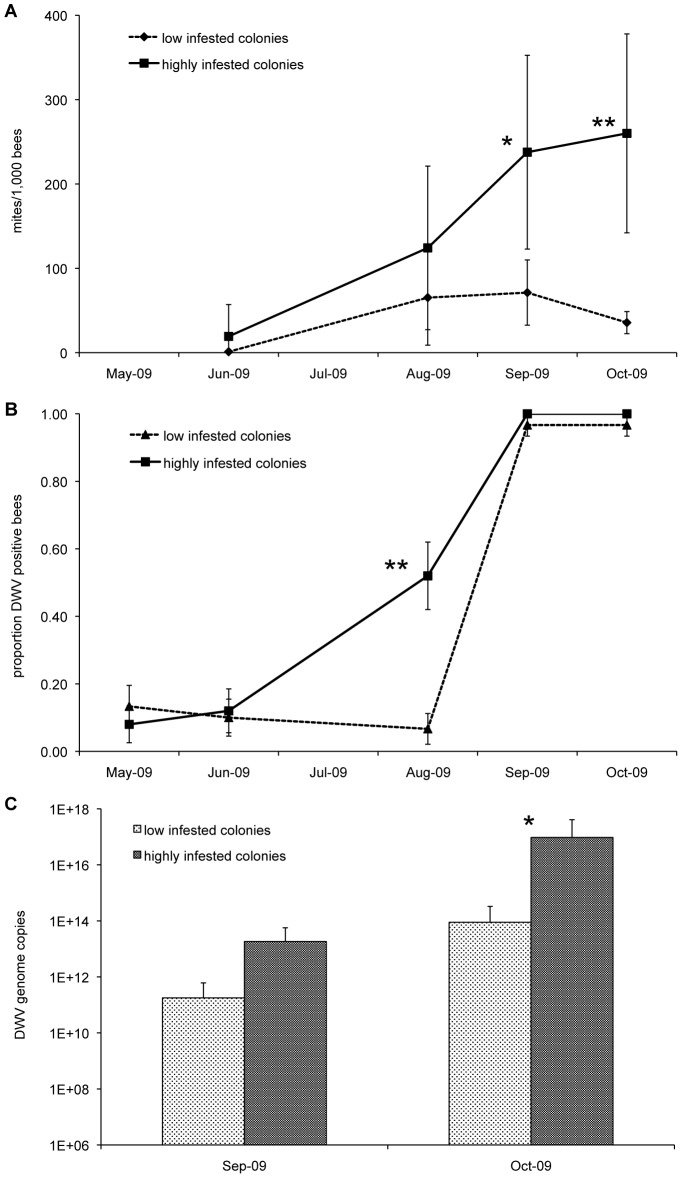
Mites and DWV in low and highly infested colonies.(A) Number of mites per 1,000 bees. (B) Seasonal prevalence of Deformed wing virus (DWV) in low and highly infested colonies. (C) Number of DWV genome copies in infected honeybees, collected in September and October from low and highly infested colonies. The error bars indicate the standard deviation; mean values significantly different are denoted with asterisks (*P≤0.05; **P≤0.01). Mite population steadily increased along the season in untreated colonies; DWV prevalence approached 100% at the end of the season both in low and highly infested colonies, but the number of genome copies was much higher in highly infested colonies.